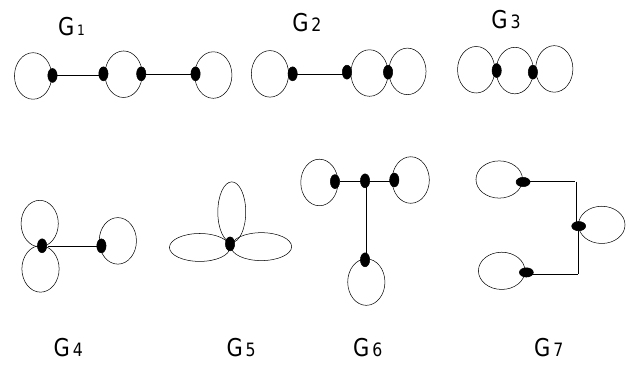
Figure 1: Tricyclic graphs with three cycles.